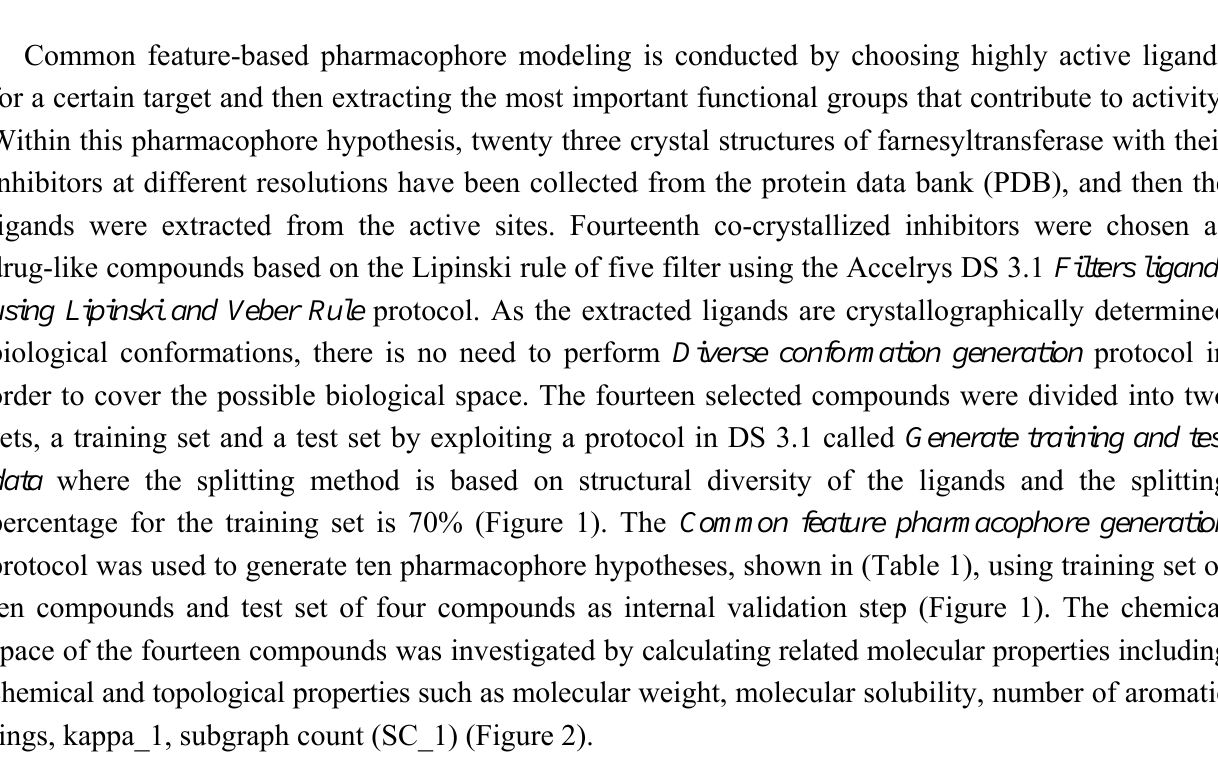
Figure 1. ( a ) Training set ligands utilized in common feature pharmacophore generation are shown with their PDB code and inhibitor name. ( b ) Test set ligands used for common feature pharmacophore validation